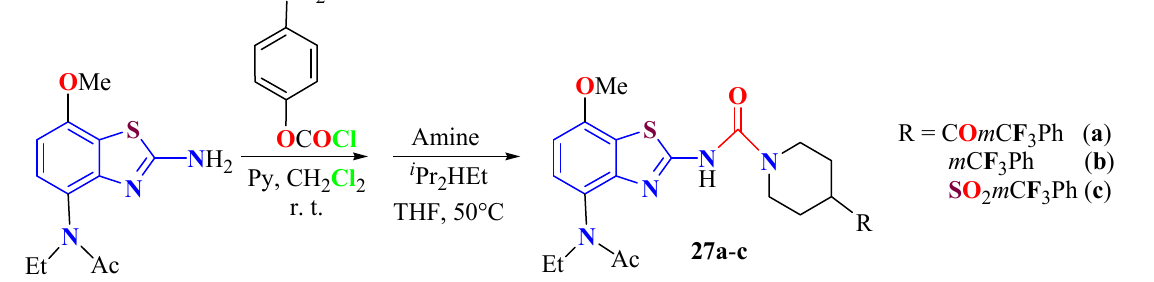
Scheme 11. Reaction of 4,7-disubstituted-2ABT with a phenyl chloroformate to synthetize 4,7-di- substituted-piperidineUBTs 27a – c .